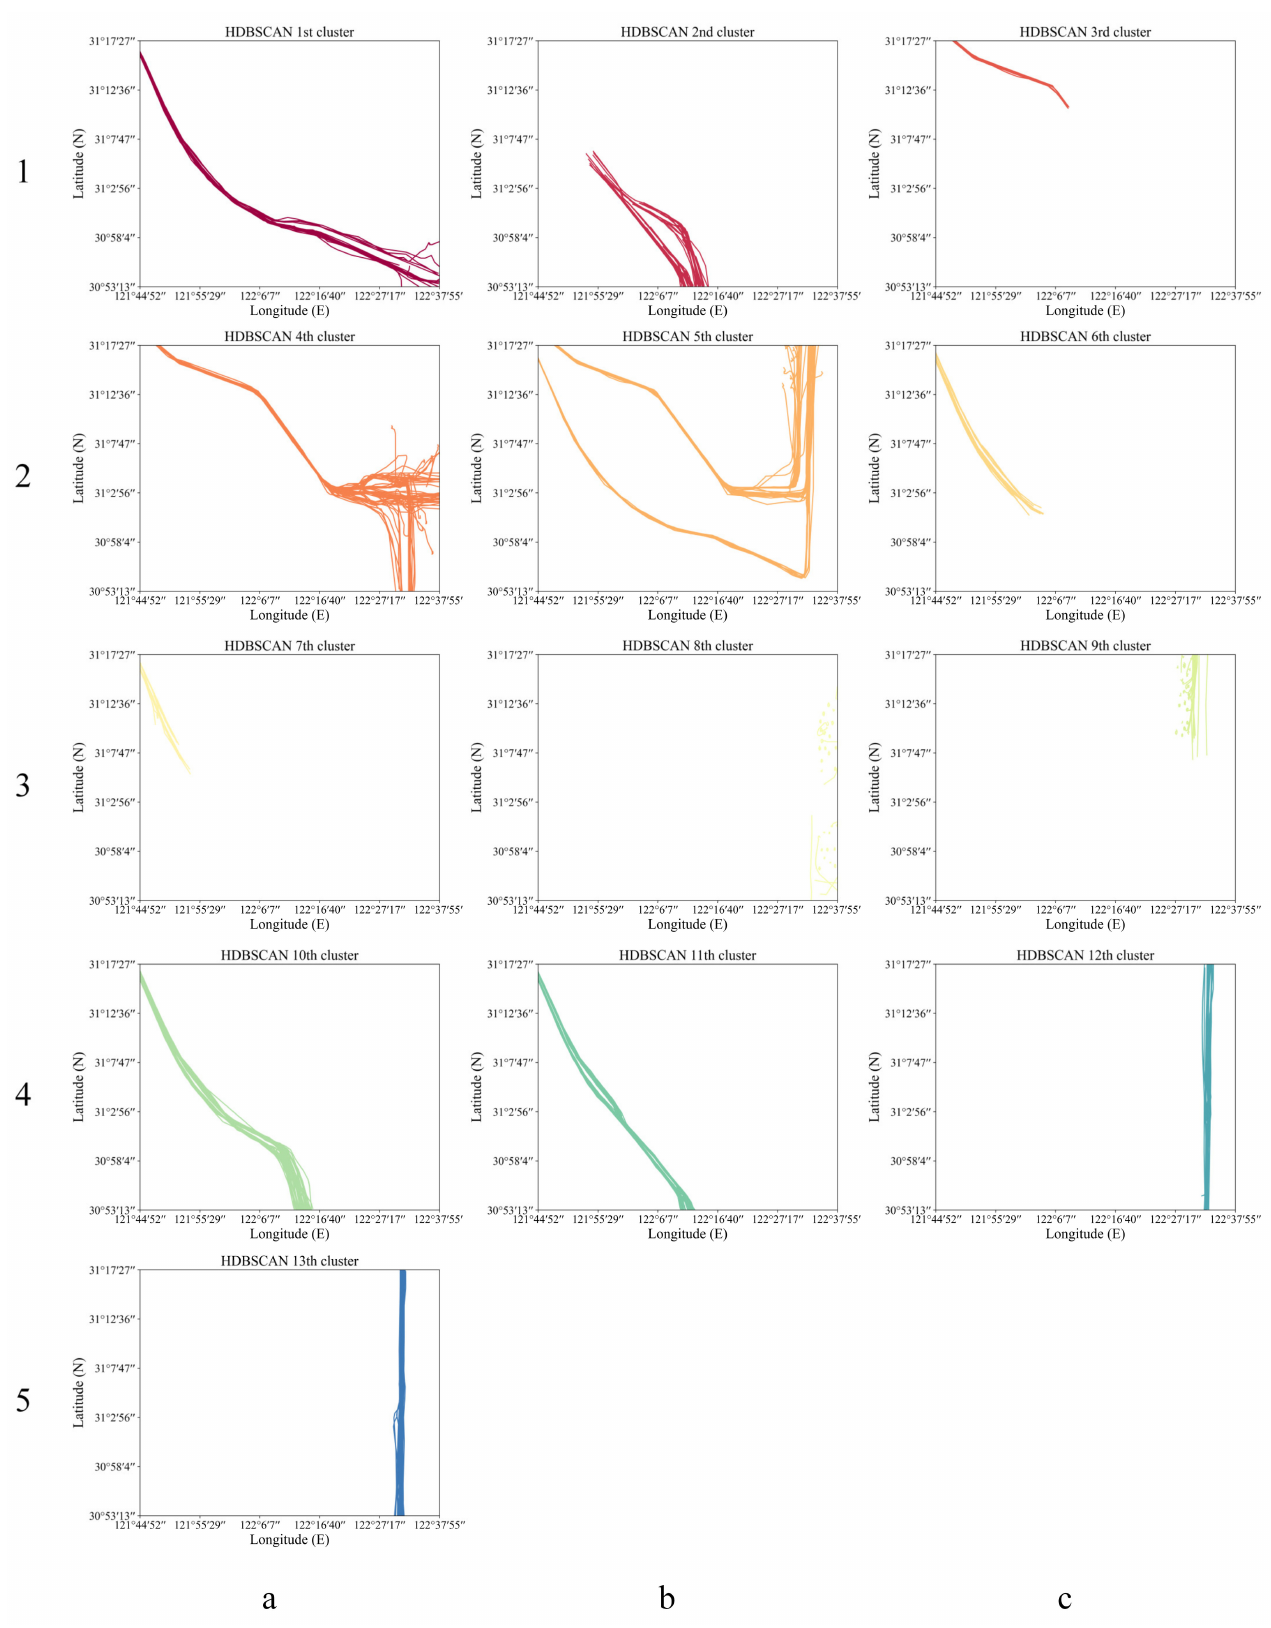
Figure 8. Illustration of clusters obtained with the proposed method (rows are labelled with numeric value and column is labelled with